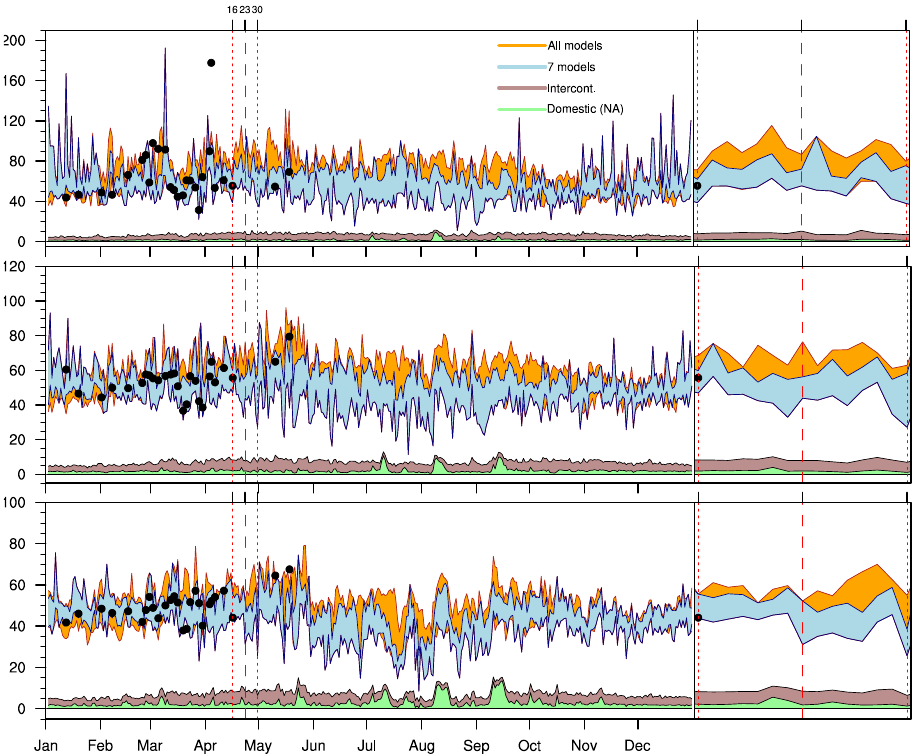
Fig. 9: Daily range of calculated ozone and stacked intercontinental (EU, EA and SA) and domestic (NA) contributions at Trinidad Head in the UT (500 - 300hPa) top, MT (700 - 500hPa) middle and LT (900 - 700hPa) bottom panel. The focused panels on the right hand side are centred around the April 23. episode, highlighted in Section 4.1.3 and bounded by red lines in the Figure. The range for the first seven models listed in Table 1 are shown in blue. The additional range, including all models in Table 1, are shown in orange. Ozone measurements from ozonesondes are marked as black dots. The model mean stacked contributions (multipl. by 5) from domestic (NA) and intercontinental (EU, EA and SA) are also shown.